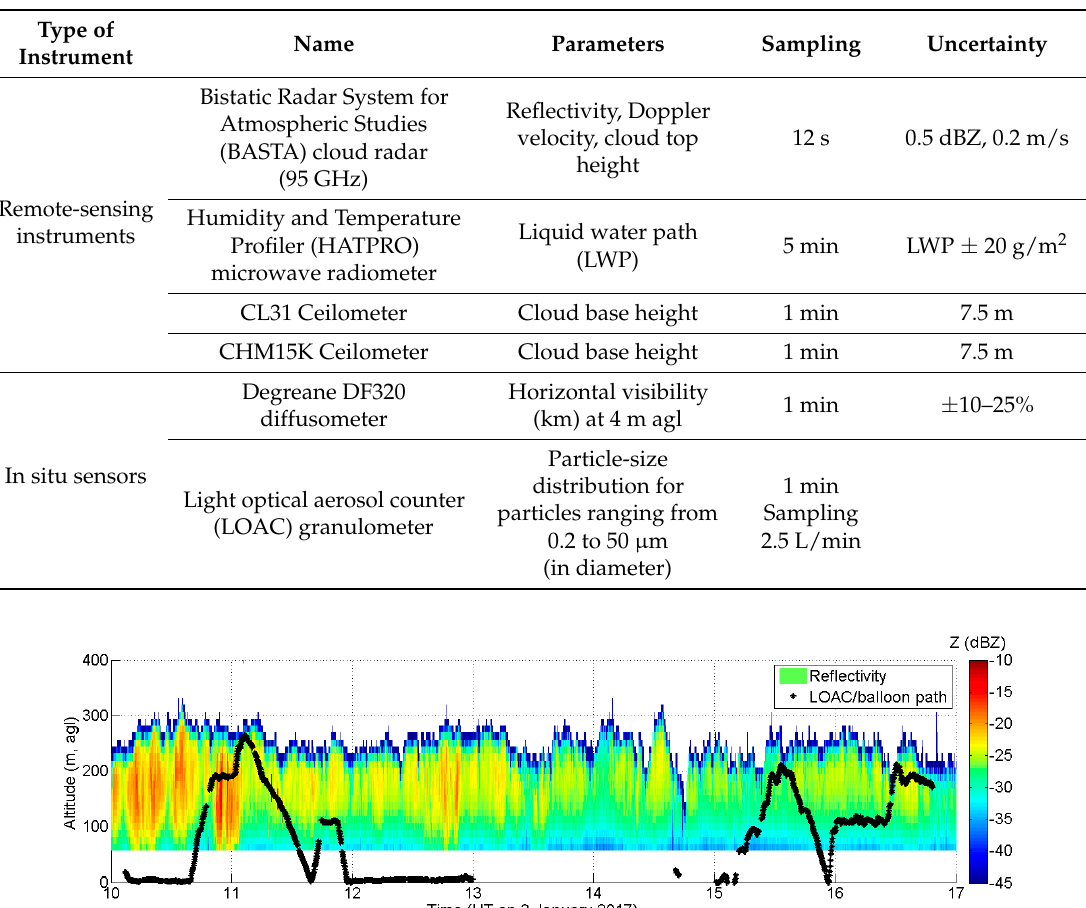
Table 1. Active and passive remote sensing instruments and the in-situ sensors deployed at the Instrumented Site for Atmospheric Remote Sensing Research (SIRTA) site and used for this study.